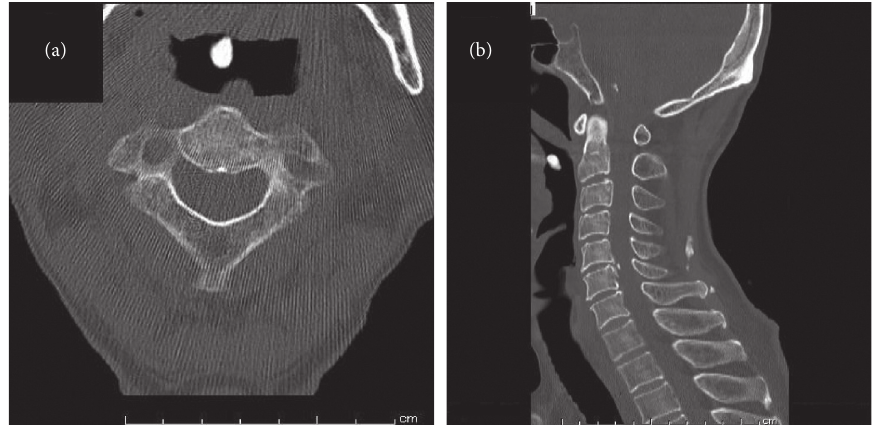
Figure 2: Computed tomography scan showing a well-defined, rounded, high-density mass with a tiny pedicle on the base of the tongue: (a) axial and (b) saggital.